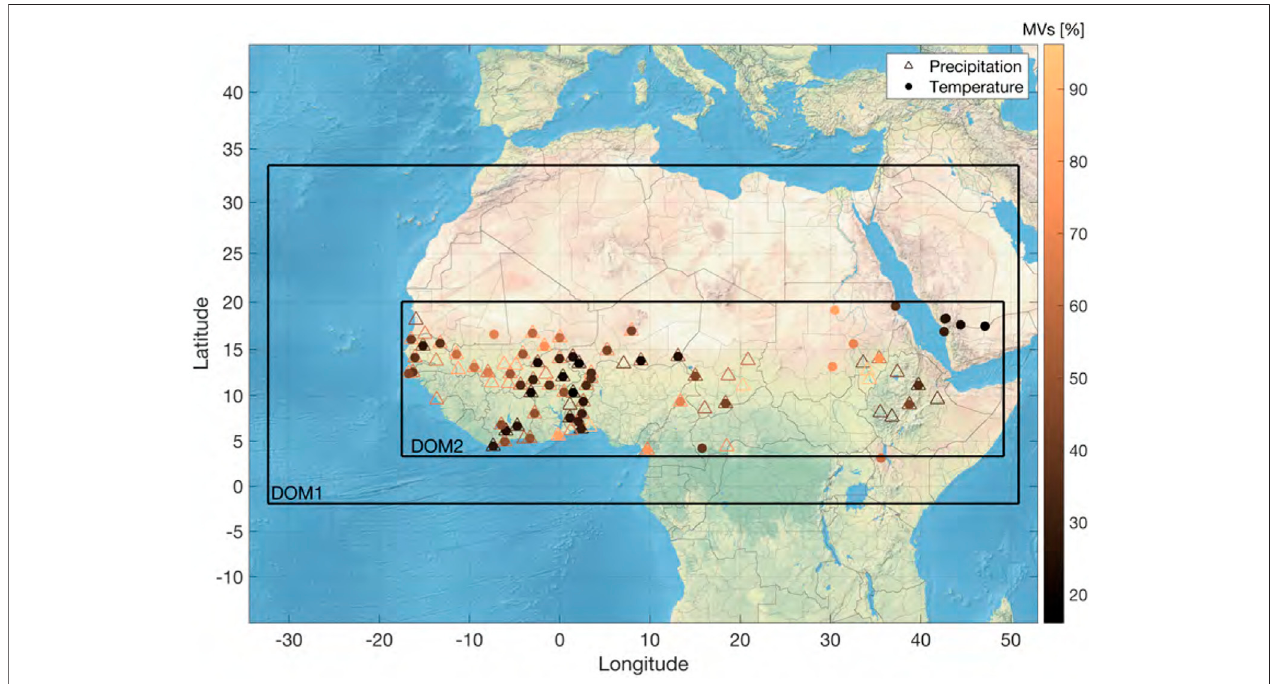
FIGURE 1 | Domain con fi guration for the WRF simulations. See Table 2 for further information about the horizontal resolutions for the different nests, respectively. Availability of observations stations from the Global Historical Climatology Network-Daily (GHCN-D) database. The color of the dots indicates the number of missing values (MVs, in % ) for the period 2006 – 2010.